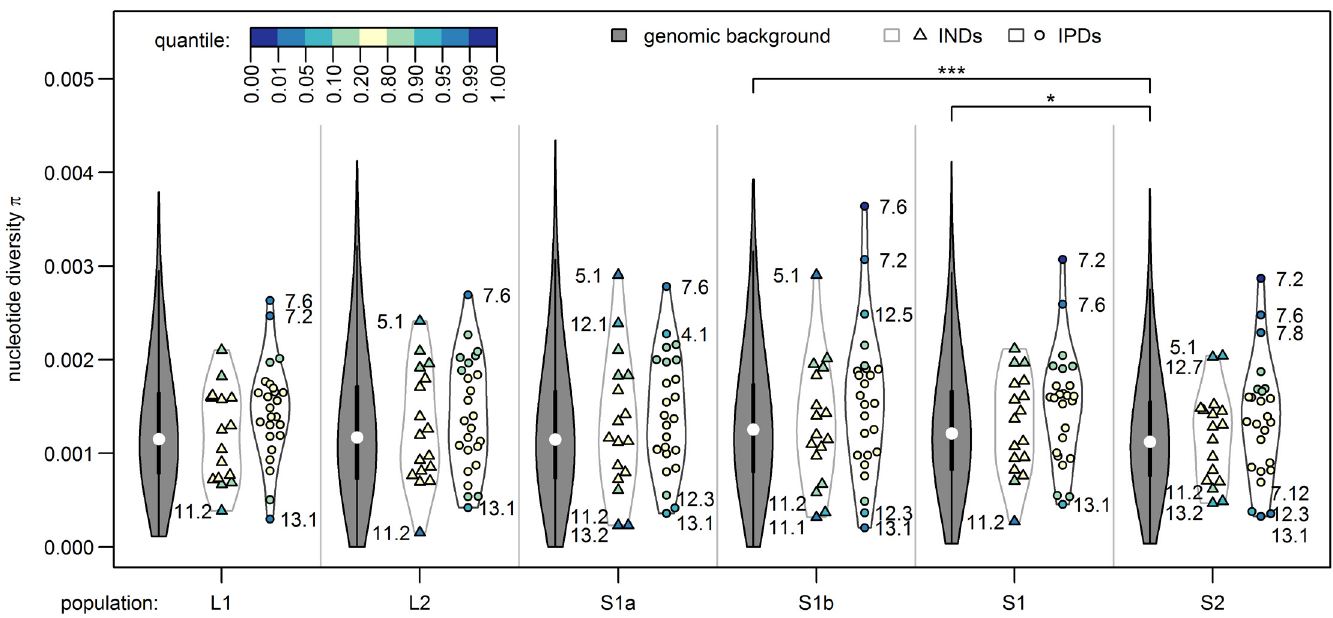
Fig 6. Nucleotide diversity inside and outside genomic islands for each population. Genomic islands of parallel differentiation (IPDs) show on average a slightly but not significantly higher diversity than both the genomic background and genomic islands of non-parallel differentiation (INDs) in all populations and diversity did not differ between populations. Nucleotide diversity was calculated in non-overlapping windows spanning multiple RAD-loci that together contained 2,500 – 2,685 sequenced bases. Windows were grouped into genomic background (n = 1,104 windows, filled violin plots), overlapping with non- parallel islands (n = 17, triangles) and with parallel islands (n = 25, circles) and tested for group differences in mean nucleotide diversity using t-tests (n.s.: not significant; * : Bonferroni-adjusted p-value < 0.05). Marker color indicates how extreme genomic island diversity is compared to the genomic background.